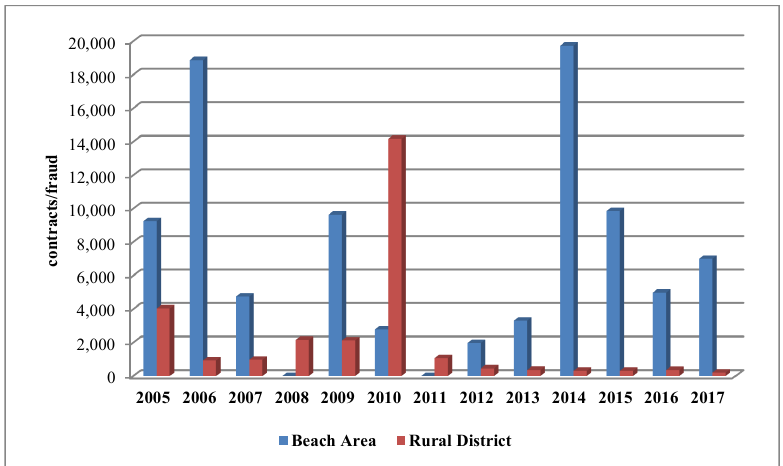
Figure 4. Evolution of the ratio contracts/frauds detected in the low density urban model (2005–2017). Source: AMAEM. Own elaboration. In 2008 and 2011 AMAEM did not detected unauthorised consumption in the Beach Area.